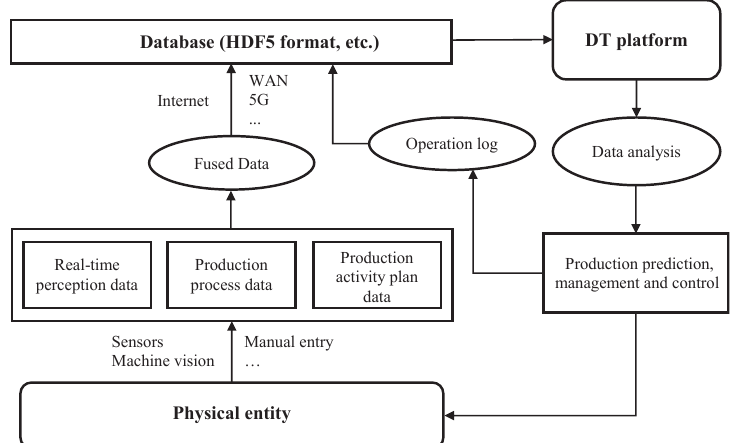
Figure 5. Data flow of DT